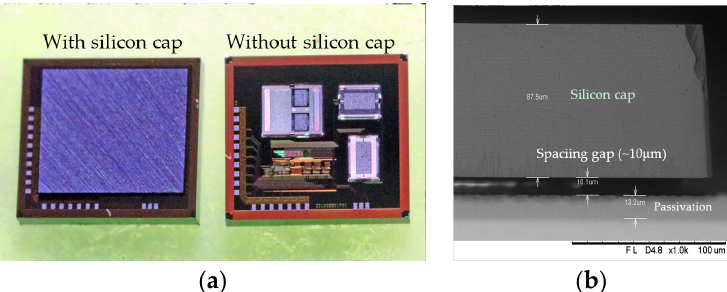
Figure 7. ( a ) Monolithic three-axis CMOS MEMS accelerometer with/without cap packaging; ( b ) SEM of cross-sectional view of silicon cap and